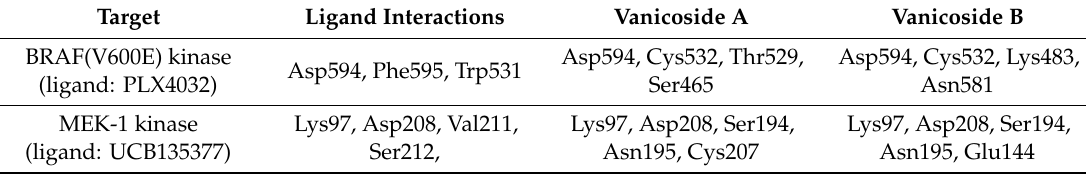
Table 1. Hydrogen bond interactions of vanicosides A and B with the BRAF(V600E) and MEK1 kinases.